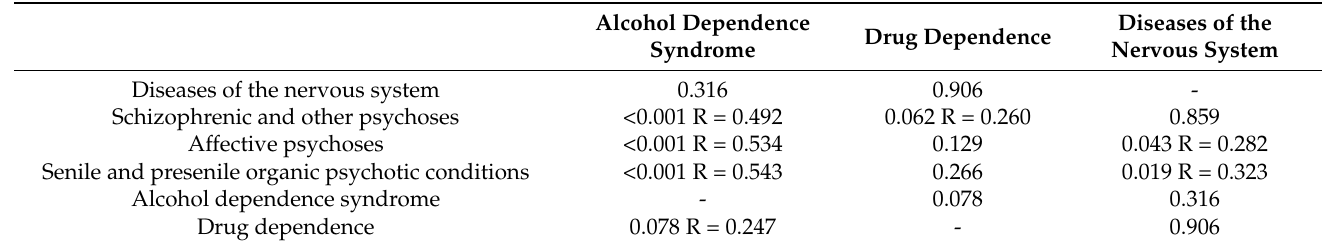
Table 4. Pearson’s correlation between sex- and age-adjusted PHR of mental disorders and diseases of the nervous system ( p -value, R: Pearson’s correlation coefficient).